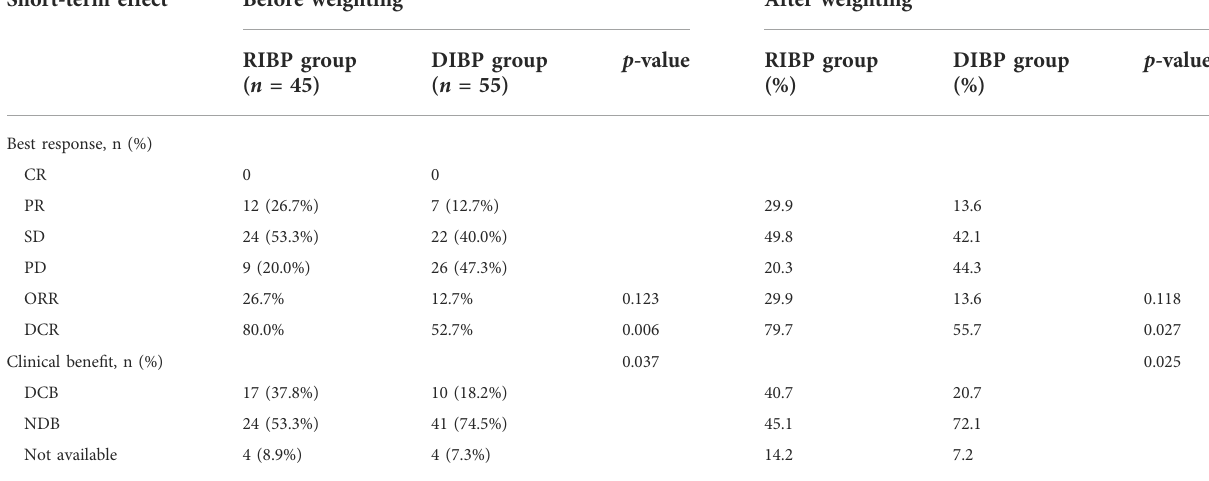
TABLE 2 Short-term effect in total population. Short-term effect